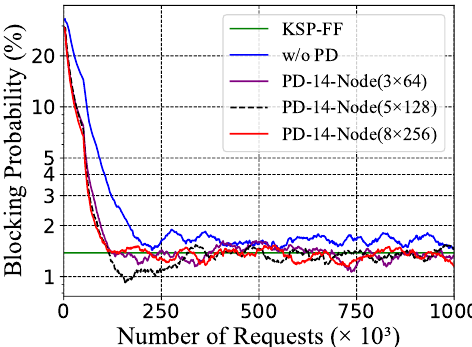
Figure 7. Blocking probability in training with different size of teacher model’s neural